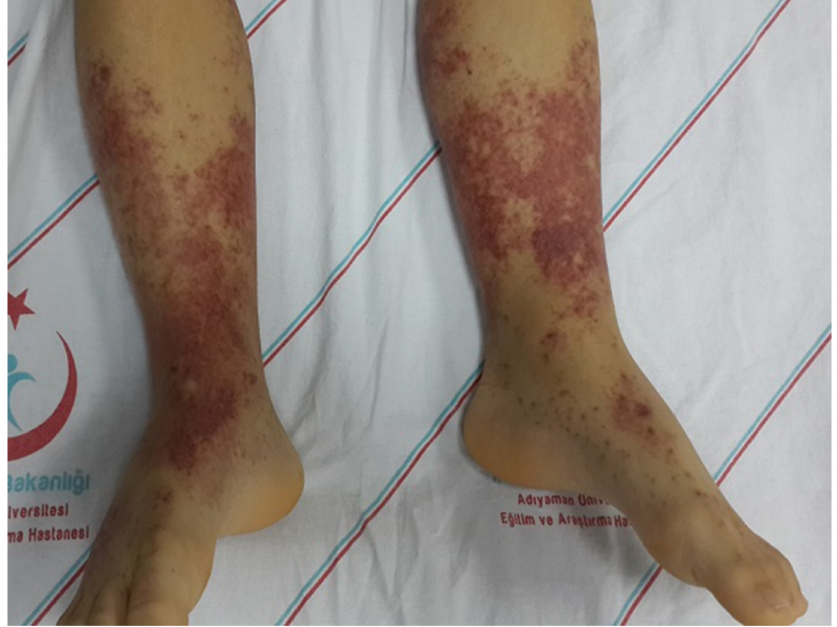
Figure 1. A child with palpable purpura in the lower